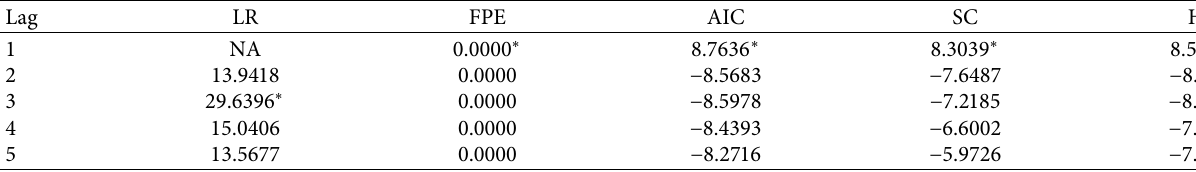
Table 5: Model VAR lag order